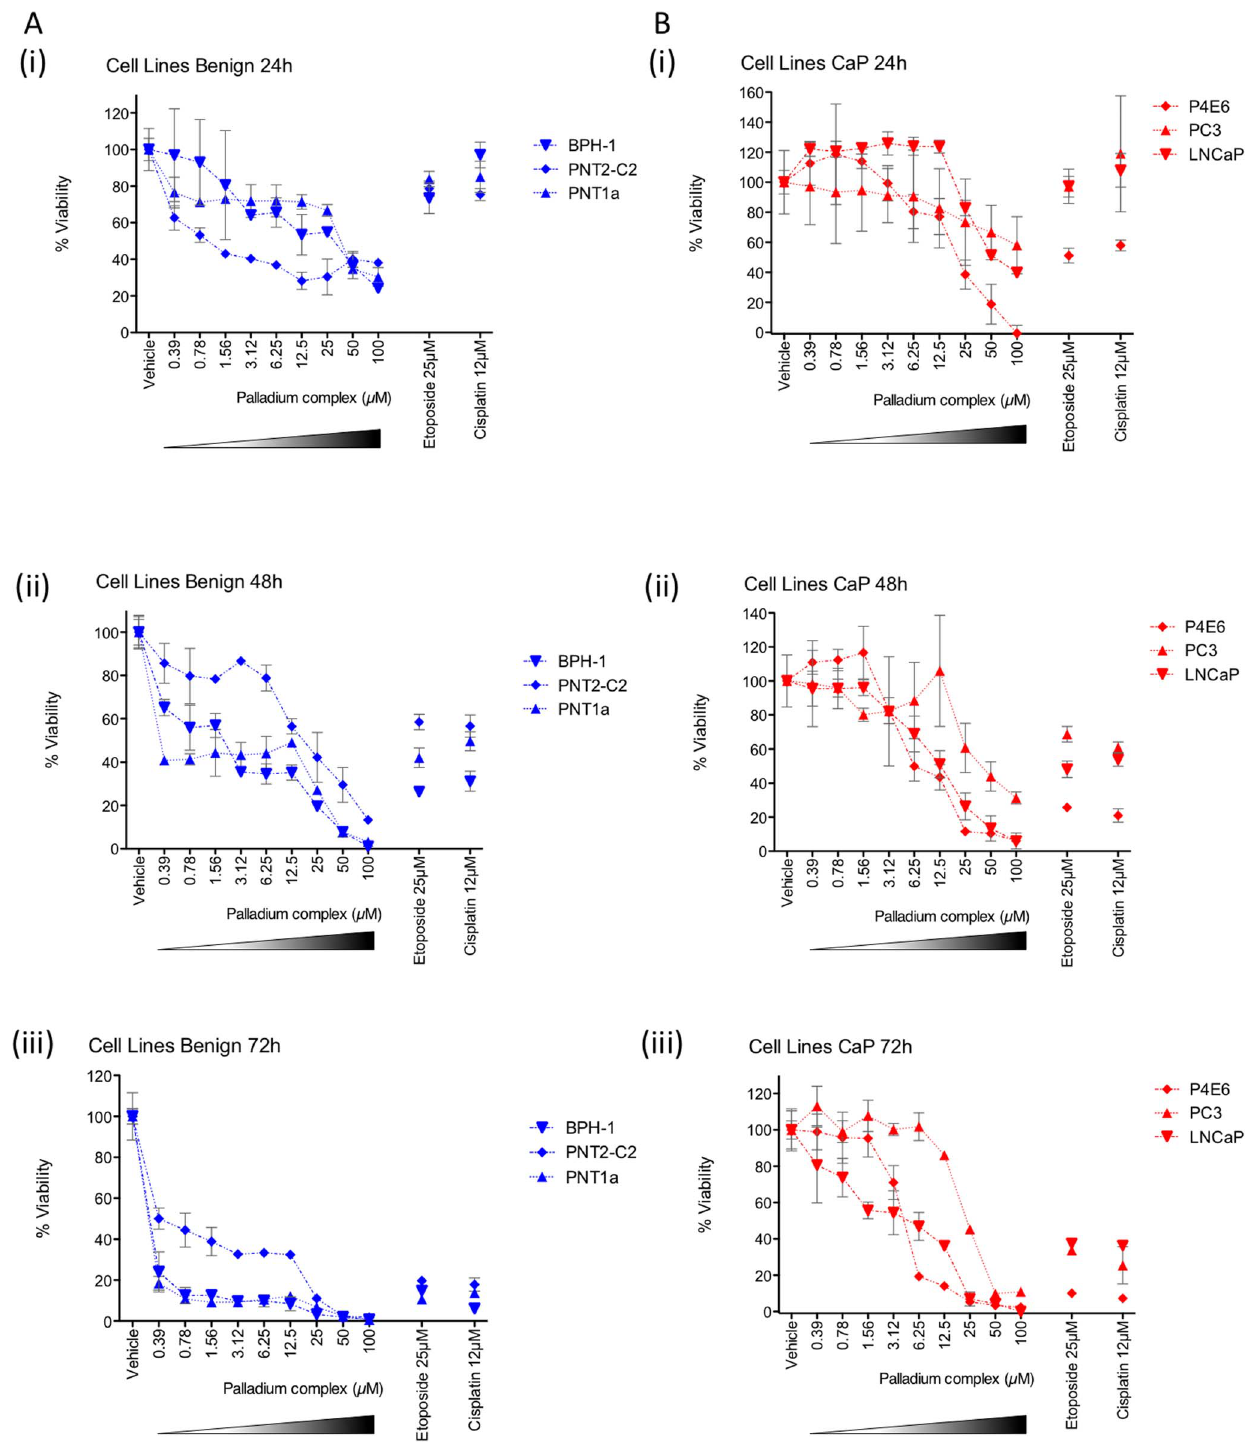
Figure 2. Anti-growth effect of the Pd complex on cell lines. Anti-growth effect was measured by the MTS assay at 24 h, 48 h and 72 h. PNT1A, PNT2-C2, and BPH-1 have either normal tissue or benign prostatic hyperplasia tissue origin (Ai–iii), while PC-3, LNCaP and P4E6 cell lines have malignant origin (Bi–iii). IC 50s are presented in Table 3. Transformed graphs are presented in Supplementary Figure S1. doi:10.1371/journal.pone.0064278.g002 content, and also induced an increase in cells with more than 4N C2 cells, LNCaPs and PC3 cells as well as primary cells. Overall, it DNA content, potentially indicative of induction of aneuploidy. appears that the Pd complex had a different effect on the cell cycle status than either etoposide or cisplatin. Similarly to etoposide, cisplatin caused an S phase arrest in PNT2-